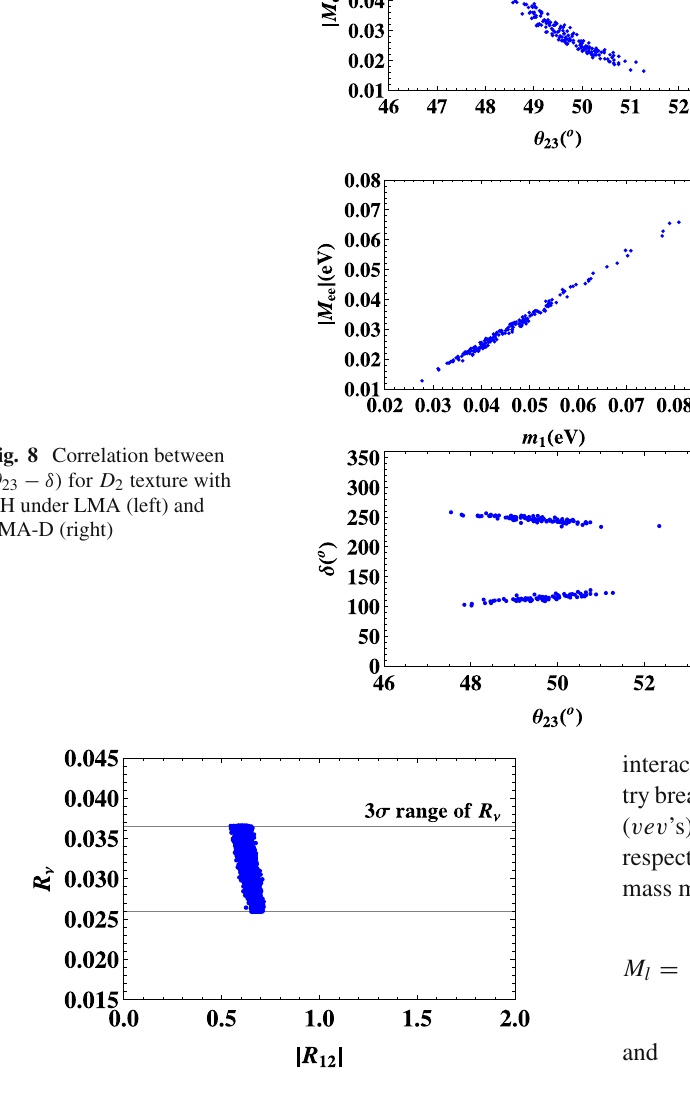
Fig. 9 Correlation between ( | R 12 | − R ν ) for texture E 1 under LMA solution with NH 1 + 2